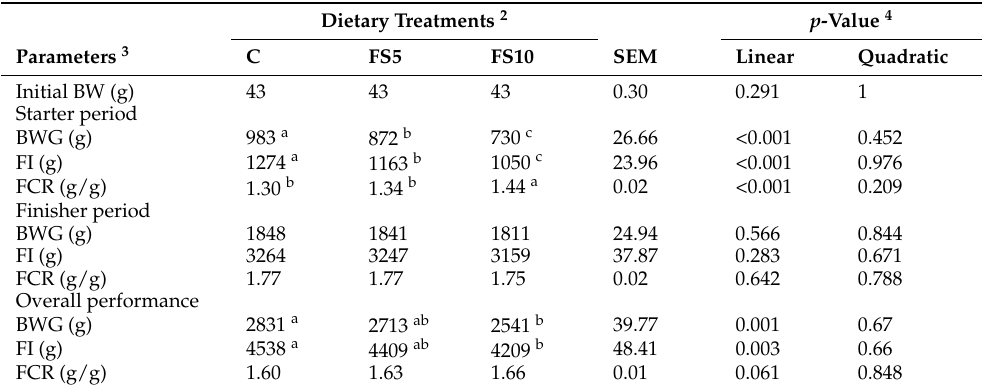
Table 4. Effect of the dietary fenugreek seed (FS) inclusion on the growth performance of male broiler chickens in Experiment 2 1 .